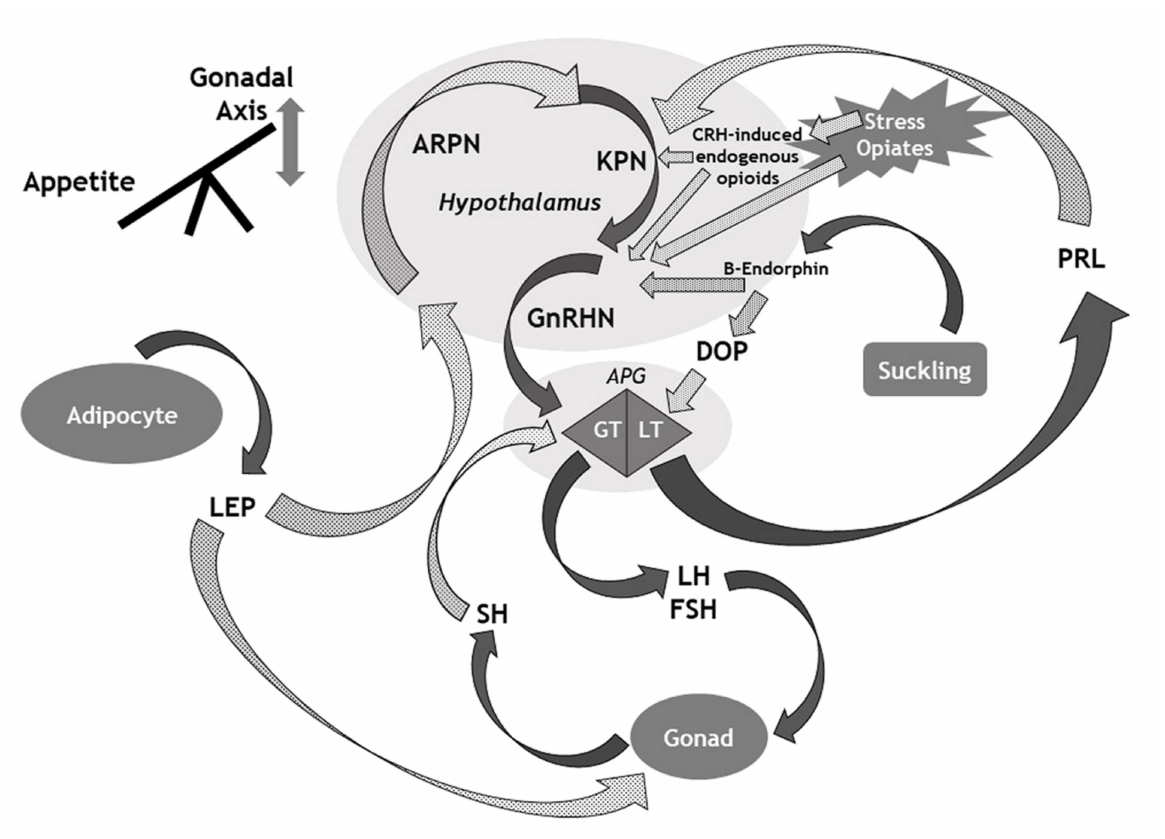
Figure 1. Overview of the main mechanisms that influence the gonadal axis. APG: Anterior pituitary gland; ARPN: Agouti-related peptide neurons; CRH: Corticotrophin-releasing hormone; DOP: Dopamine; FSH: Follicle stimulating hormone; GnRHN: Gonadotrophin releasing hormone neurons; GT: Gonadotroph cells; KPN: Kisspeptin neurons; LEP: Leptin; LH: Luteinising hormone; LT: Lactotroph cells; PRL: Prolactin; SH: Sex hormone. Solid arrows denote stimulatory effects (or hormonal release); Dotted (grey) arrows denote suppressive